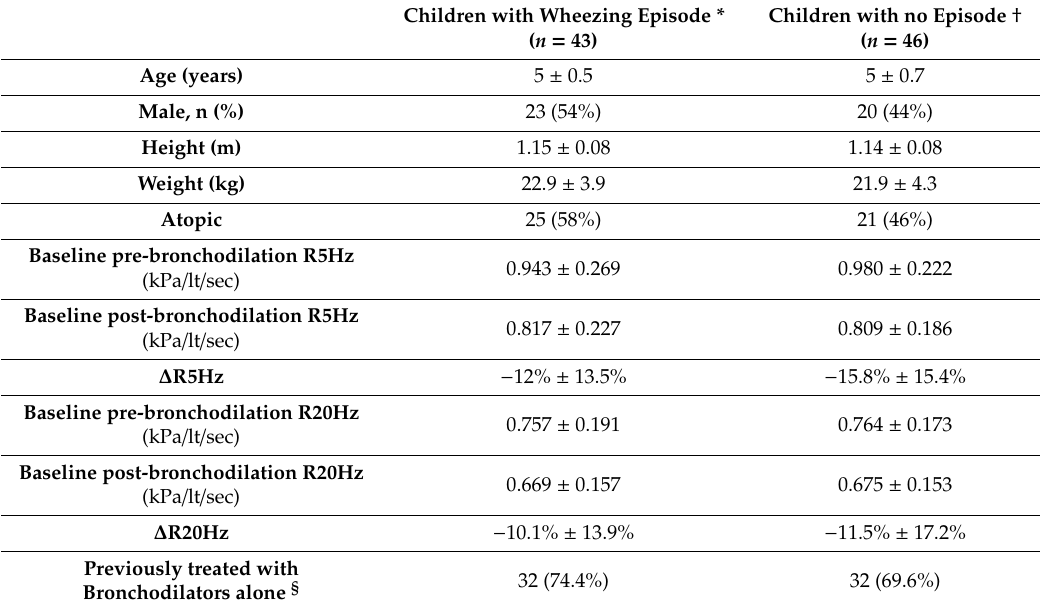
Table 1. Baseline characteristics of children experiencing a wheezing episode during the study period, and children without a wheezing episode during the study period. Children with Wheezing Episode * ( n =